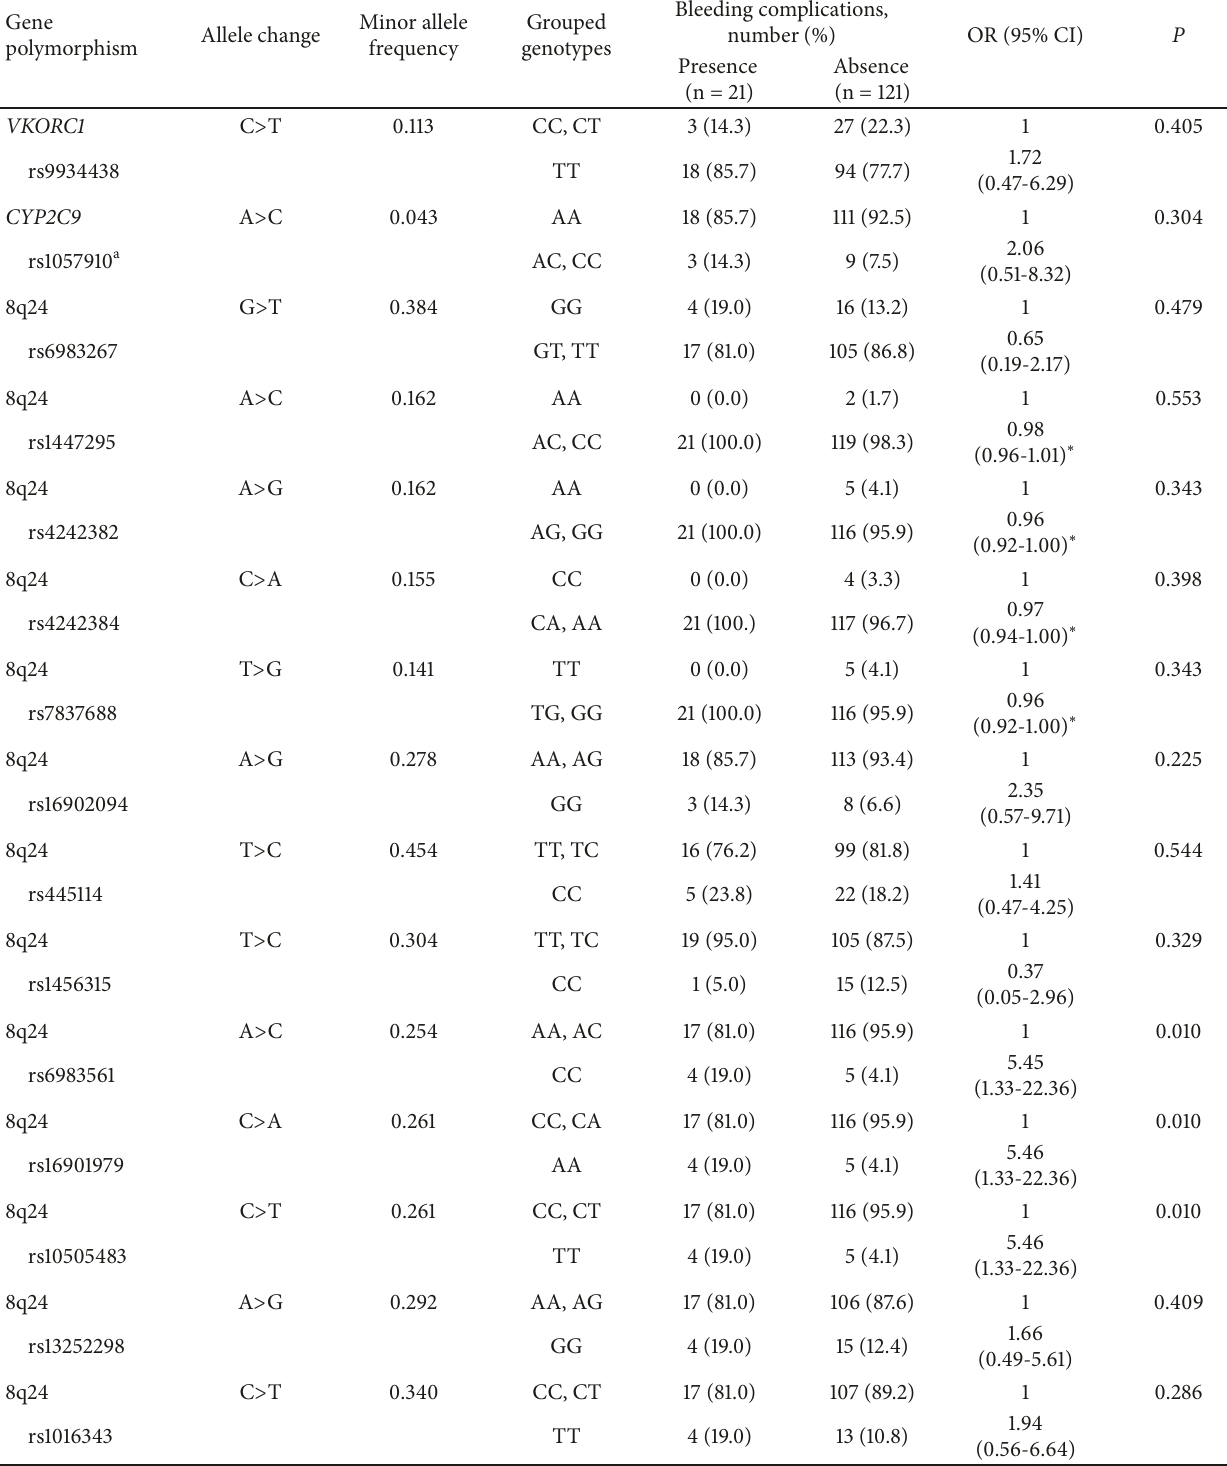
Table 2: Factors associated with bleeding complications at a therapeutic